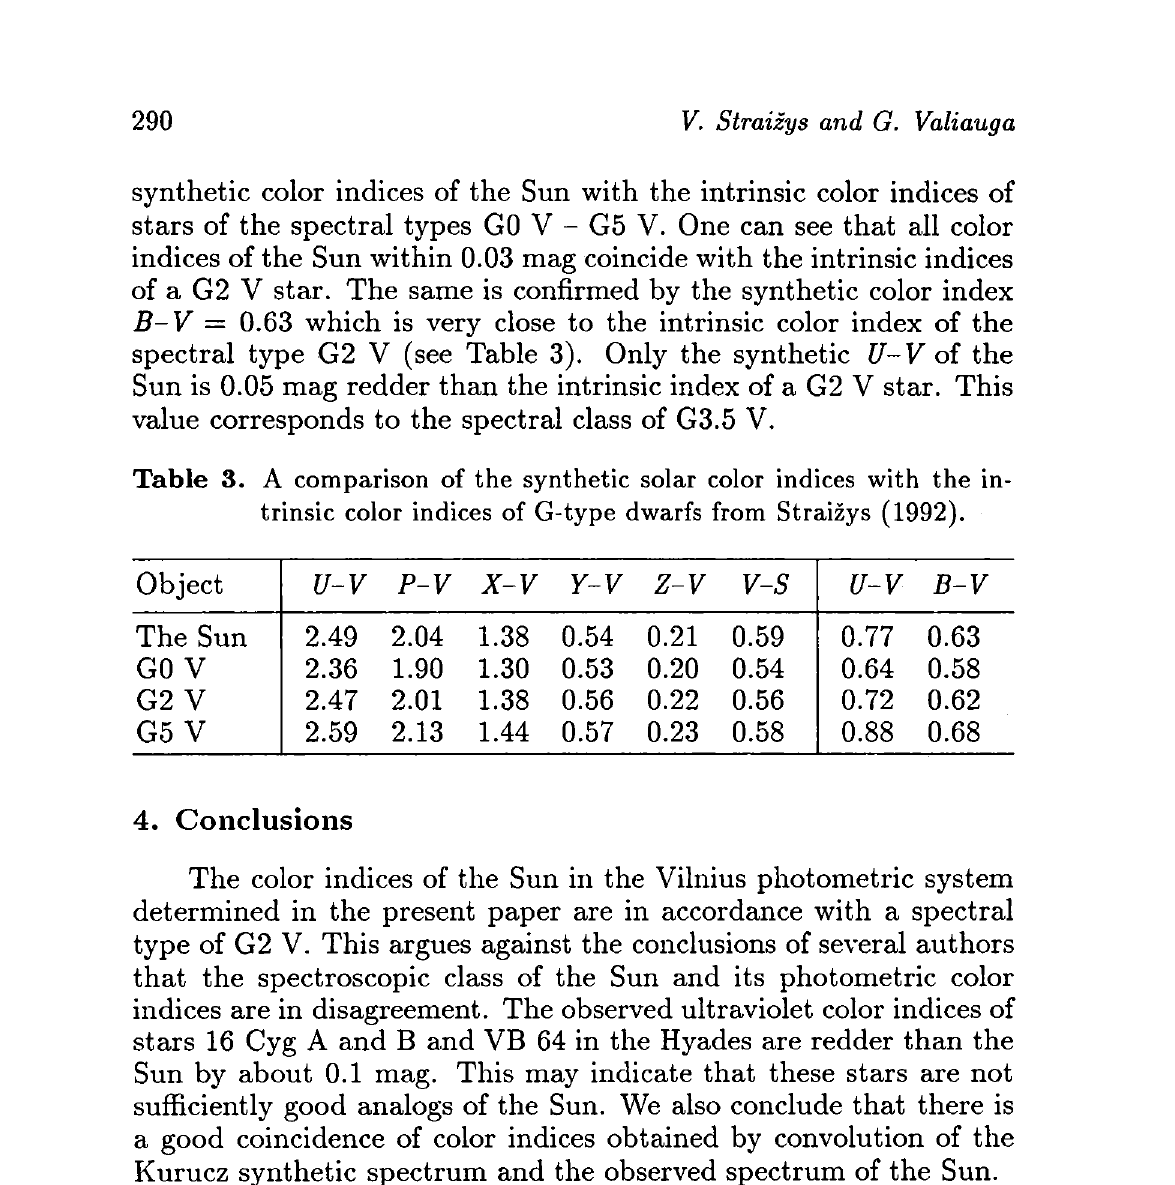
Table 3. A comparison of the synthetic solar color indices with the in- trinsic color indices of G-type dwarfs from Straizys